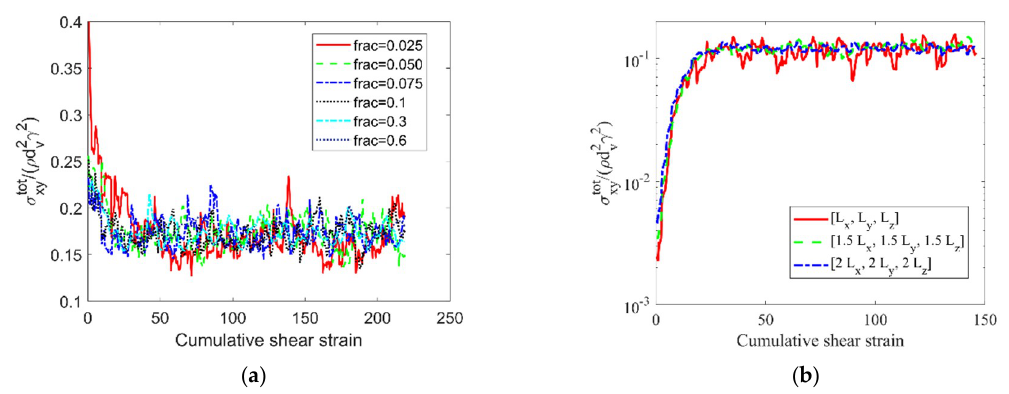
Figure 3. Evolution of normalized shear stress for ( a ) the binary mixture of AR = 0.3 and AR = 6 at the solid volume fraction ν = 0.4 with di ff erent time steps and ( b ) the binary mixture of AR = 0.3 and AR = 6 at ν = 0.05 with di ff erent shear domain sizes. Rods fraction is C = 0.5 for the two mixtures. The base shear flow domain has the dimensions [ L x = 30.25 d v , L y = 30.25 d v , L z = 15.13 d v ]. To